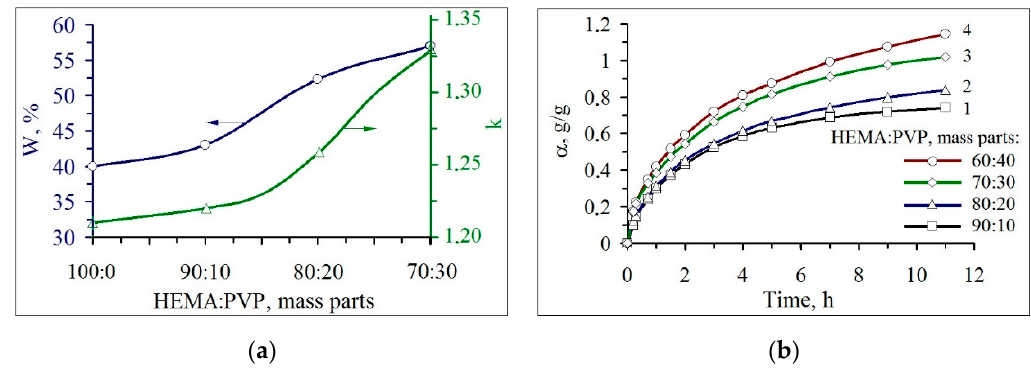
Figure 5. The e ff ect of the initial composition formulation on the water content, the coe ffi cient of Figure 5. The effect of the initial composition formulation on the water content, the coefficient of swelling ( a ) and the kinetics of changes in the swelling degree α ( b ) of the copolymers.